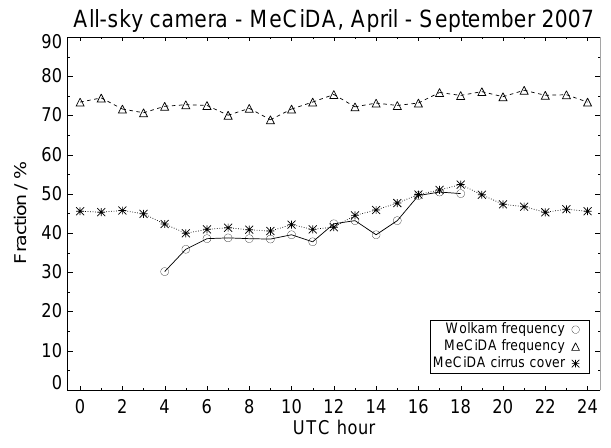
Fig. 8. Diurnal cycles of the frequency of “All ice clouds” occur- rence obtained from all-sky camera data ( (cid:13) ) and via the MeCiDA algorithm ( 4 ) and the diurnal cycle of cirrus cloud coverage gained from MeCiDA ( ∗